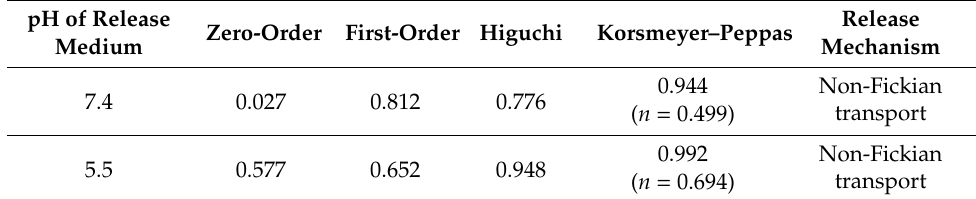
Table 2. R 2 values evaluated for kinetic modeling of in vitro drug release studies at pH values of 7.4 and 5.5.